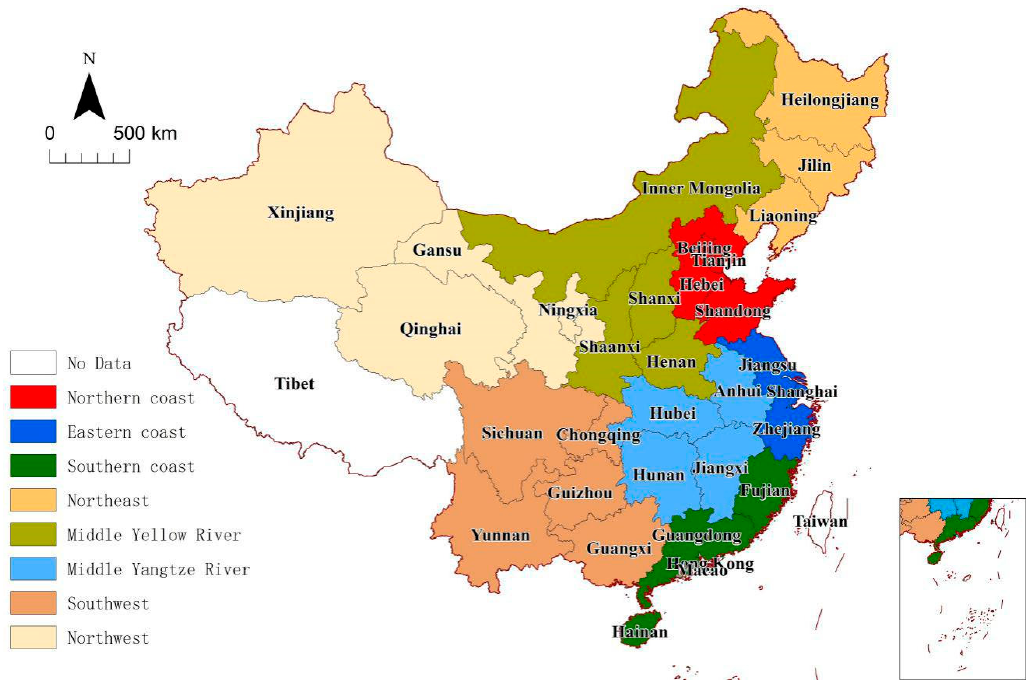
Figure 3. The schematic diagram of the eight economic zones of China. Table 4. Carbon emission efficiency in the Chinese eight regions.